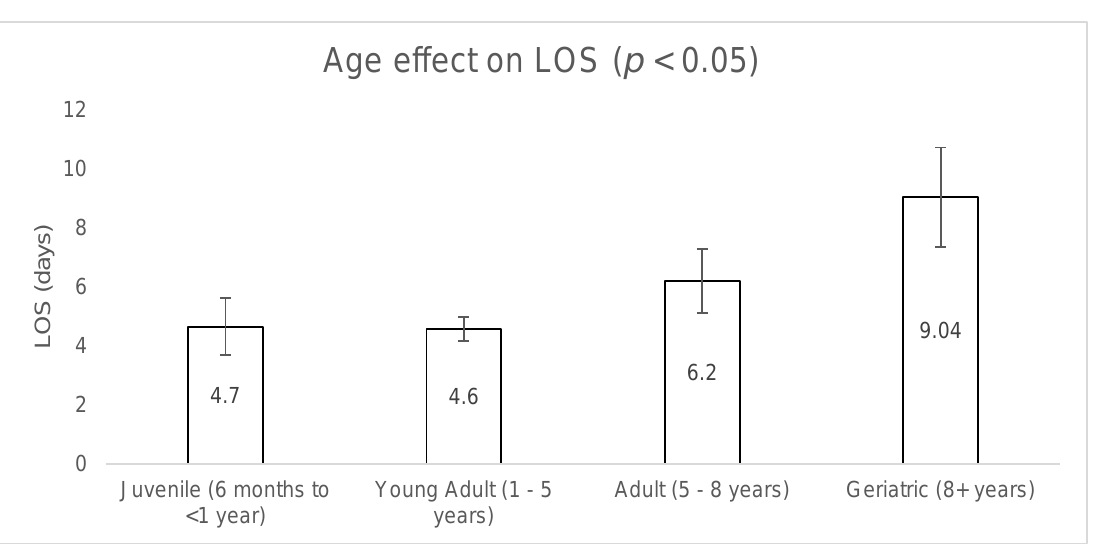
Figure 1. Effect of age on LOS. Age was found to have a significant effect, with juvenile and young adult cats rehomed faster than adult and geriatric cats ( p = 0.009). Table 4. REML univariate model output assessing interactions between predictor values and LOS.